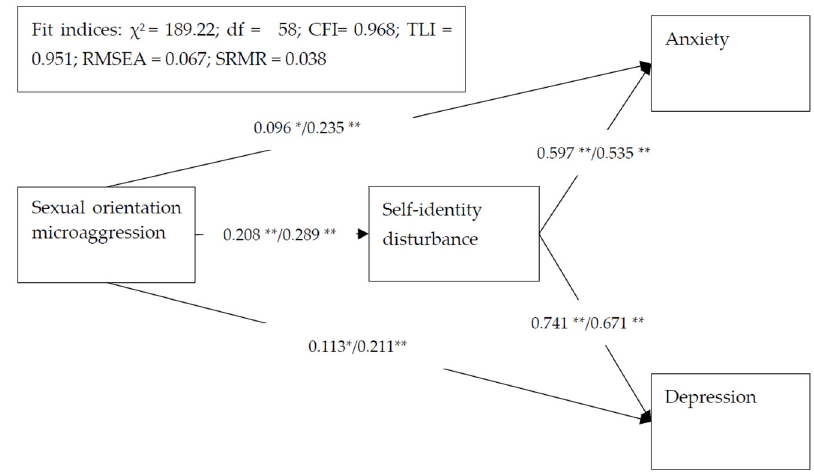
Figure 2. Multigroup structural equation model results with standardized regression coefficients for the proposed model. Age was controlled in the model. Standardized regression coefficients presented for the male sample/female sample; no moderated effects in sex were observed ( p -values of χ 2 difference tests = 0.09 to 0.92). * p < 0.05; ** p < 0.001.